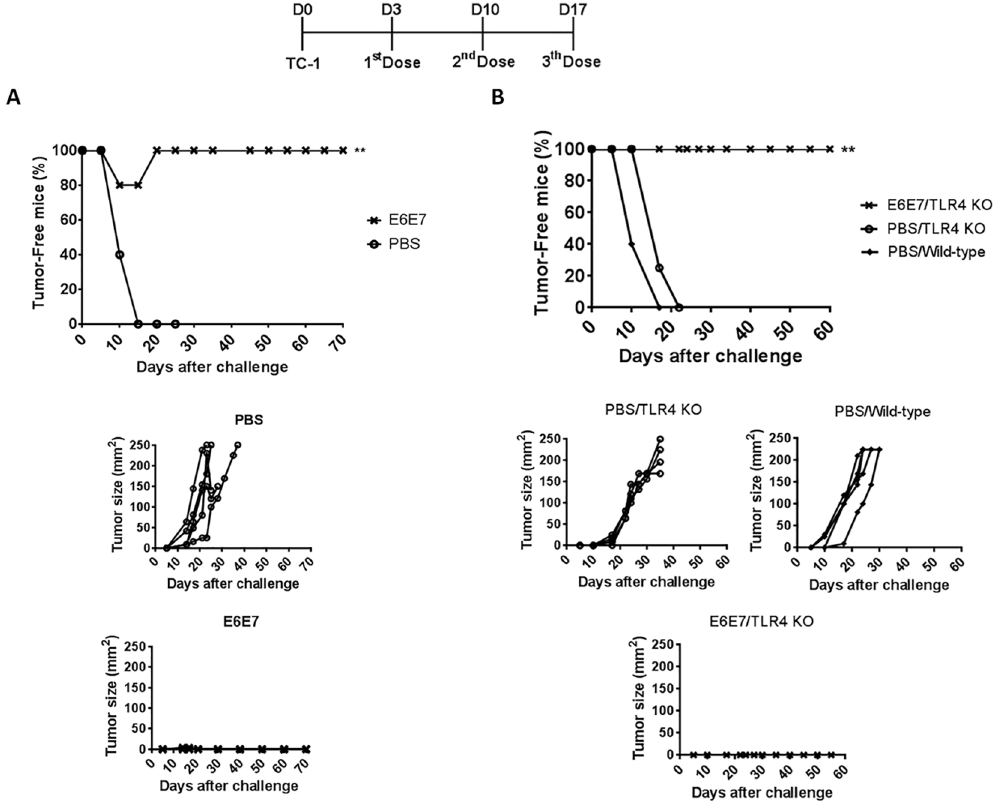
Fig 3. Therapeutic anti-tumor responses elicited in mice immunized with E6E7. (A) Groups of five C57BL/6 mice were treated with three doses of PBS/ 2M urea (PBS) or E6E7 in intervals of seven days. The first dose was administered three days after the challenge with TC-1 tumor cells. (B) Groups of TLR4 knockout mice were treated with three doses of PBS/2M urea (4 mice, PBS) or E6E7 (4 mice) in intervals of seven days. In parallel, C57BL/6 wild-type mice (5 mice) were used as a control of tumor growth competence. The tumor size in each animal was monitored daily and is given in mm 2 (length x